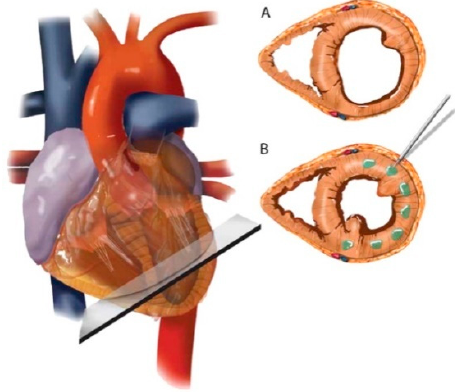
Figure 7. Schematic of Algisyl-LVR™ injection in the left ventricle. ( A ) Short-axis view of the mid-ventricle, half way between the apex and base. ( B ) Algisyl-LVR™ is injected at 10 to 15 locations at the mid-ventricle free wall (excluding the septum). A left thoracotomy is performed to expose the heart and the pericardium. The total number of injections for an individual patient depended on the size of the heart. Injections were separated by ≈ 0.5–1 cm and made at the mid-wall depth of myocardium. Reproduced with permission from Elsevier (2013) [162].